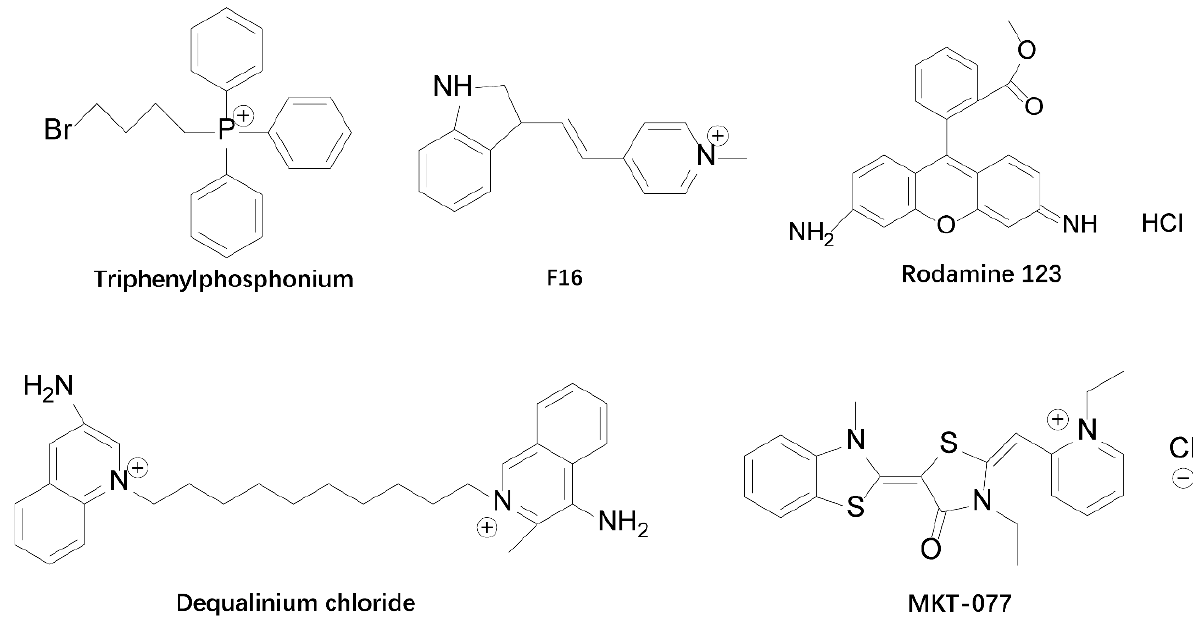
Figure 1. Chemical structure of some DLCs. DLCs can selectively target mitochondria driven by mitochondrial membrane potential, and they have been widely used as mitochondrial targeting carriers.